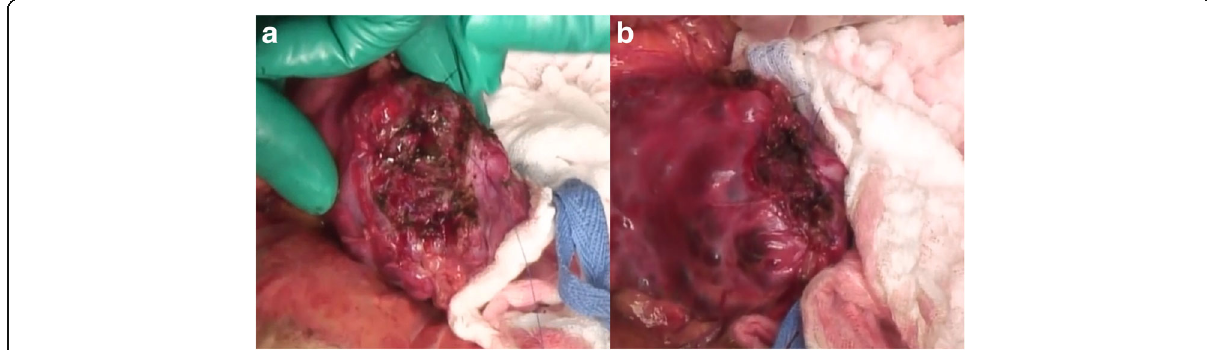
Fig. 4 Intraoperative photographs demonstrating the stump of the pancreas before ( a ) and after ( b )